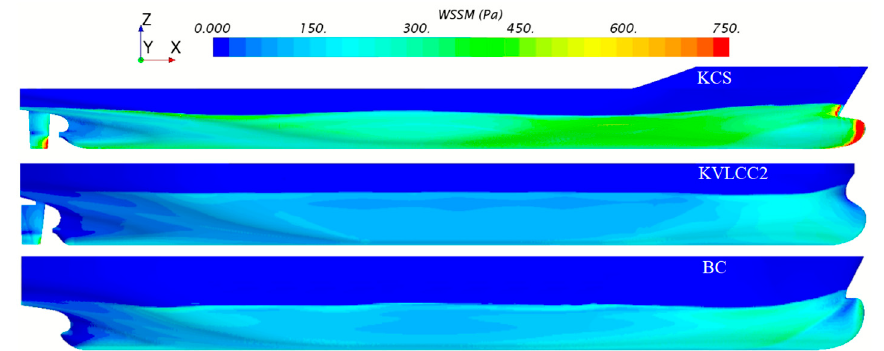
Figure 16. The obtained τ w distributions for R1 fouling condition along the KCS ( upper ), KVLCC2 ( middle ) and BC ( lower ) hull.